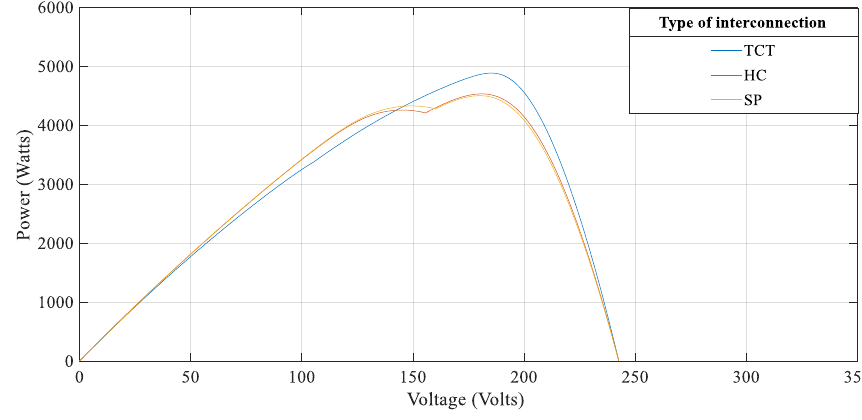
(cid:48) (thin-film PV).